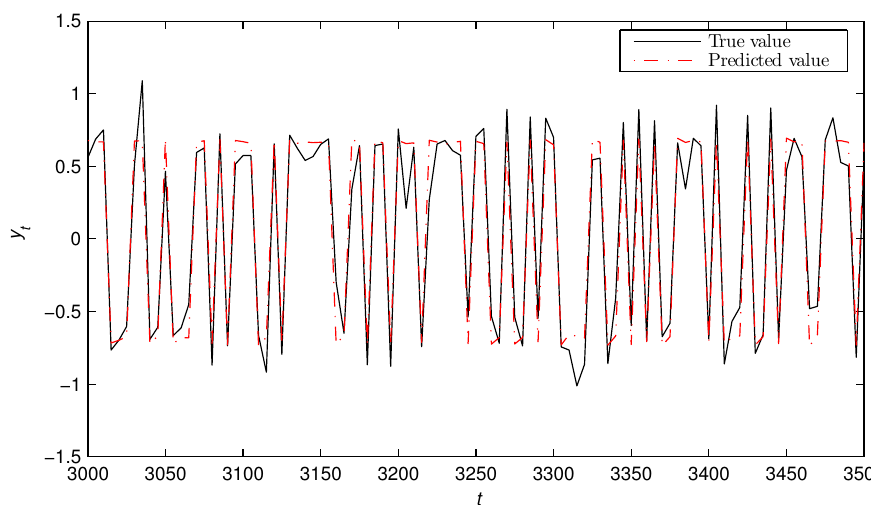
Figure 3. The F-TS-RGLS parameter estimation errors versus t with different variances.